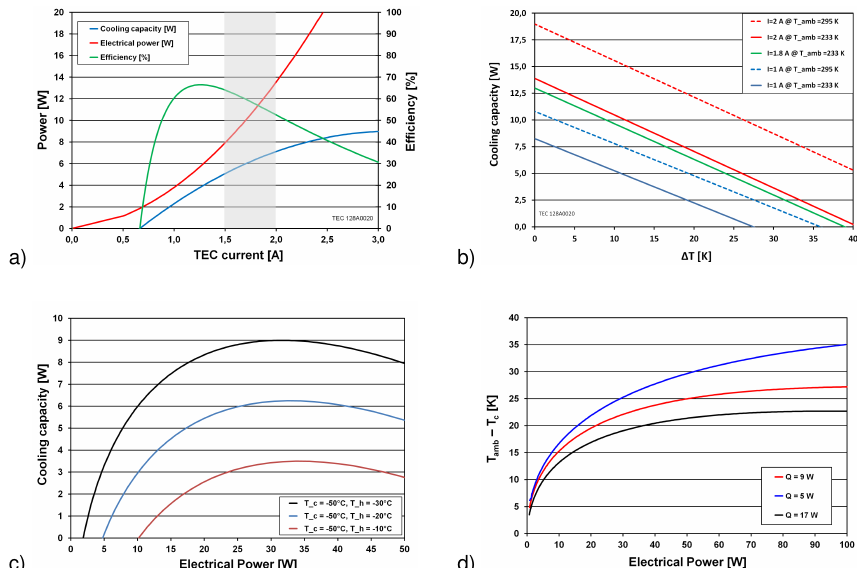
Fig. 7. TEC 128A0020 performance: (a) calculation for T c = − 50 ◦ C and T h = − 30 ◦ C as a function of TEC current, (b) cooling capacity at various ambient temperatures, (c) cooling capacity at various temperature differences between T h and T c with T c = − 50 ◦ C and (d) maximum achievable ∆ T as a function of electrical power for different external heat loads Q .